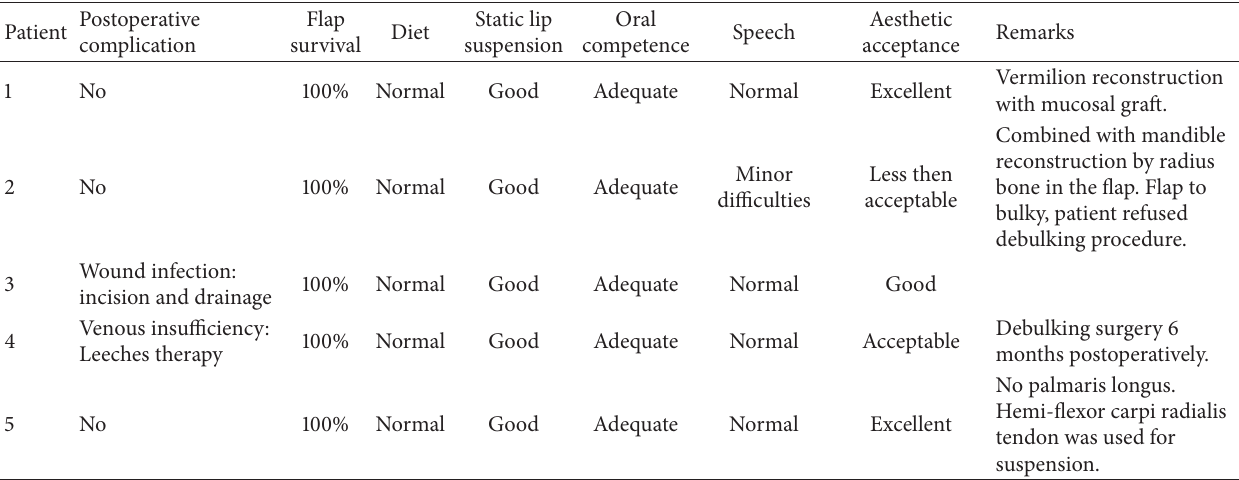
Table 2: Patients